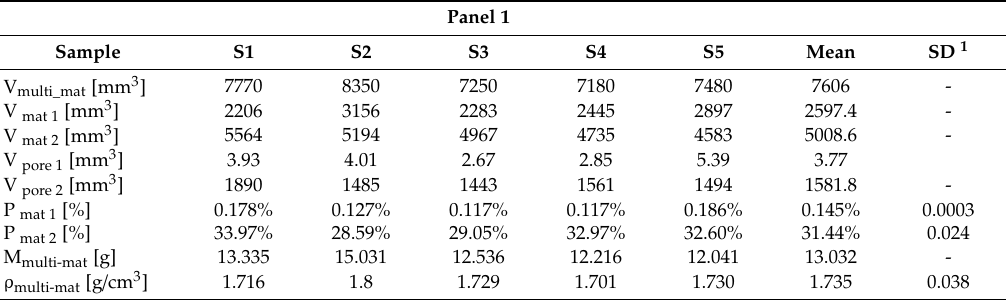
Table 2. Material characterization for the first experiment (panel 1).